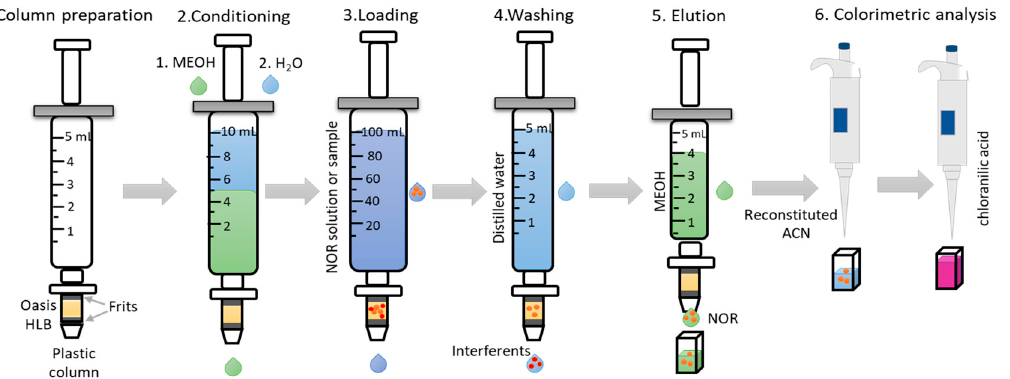
Figure 3. Schematic representation of the norfloxacin preconcentration procedure for further color- imetric analysis based on digital images.